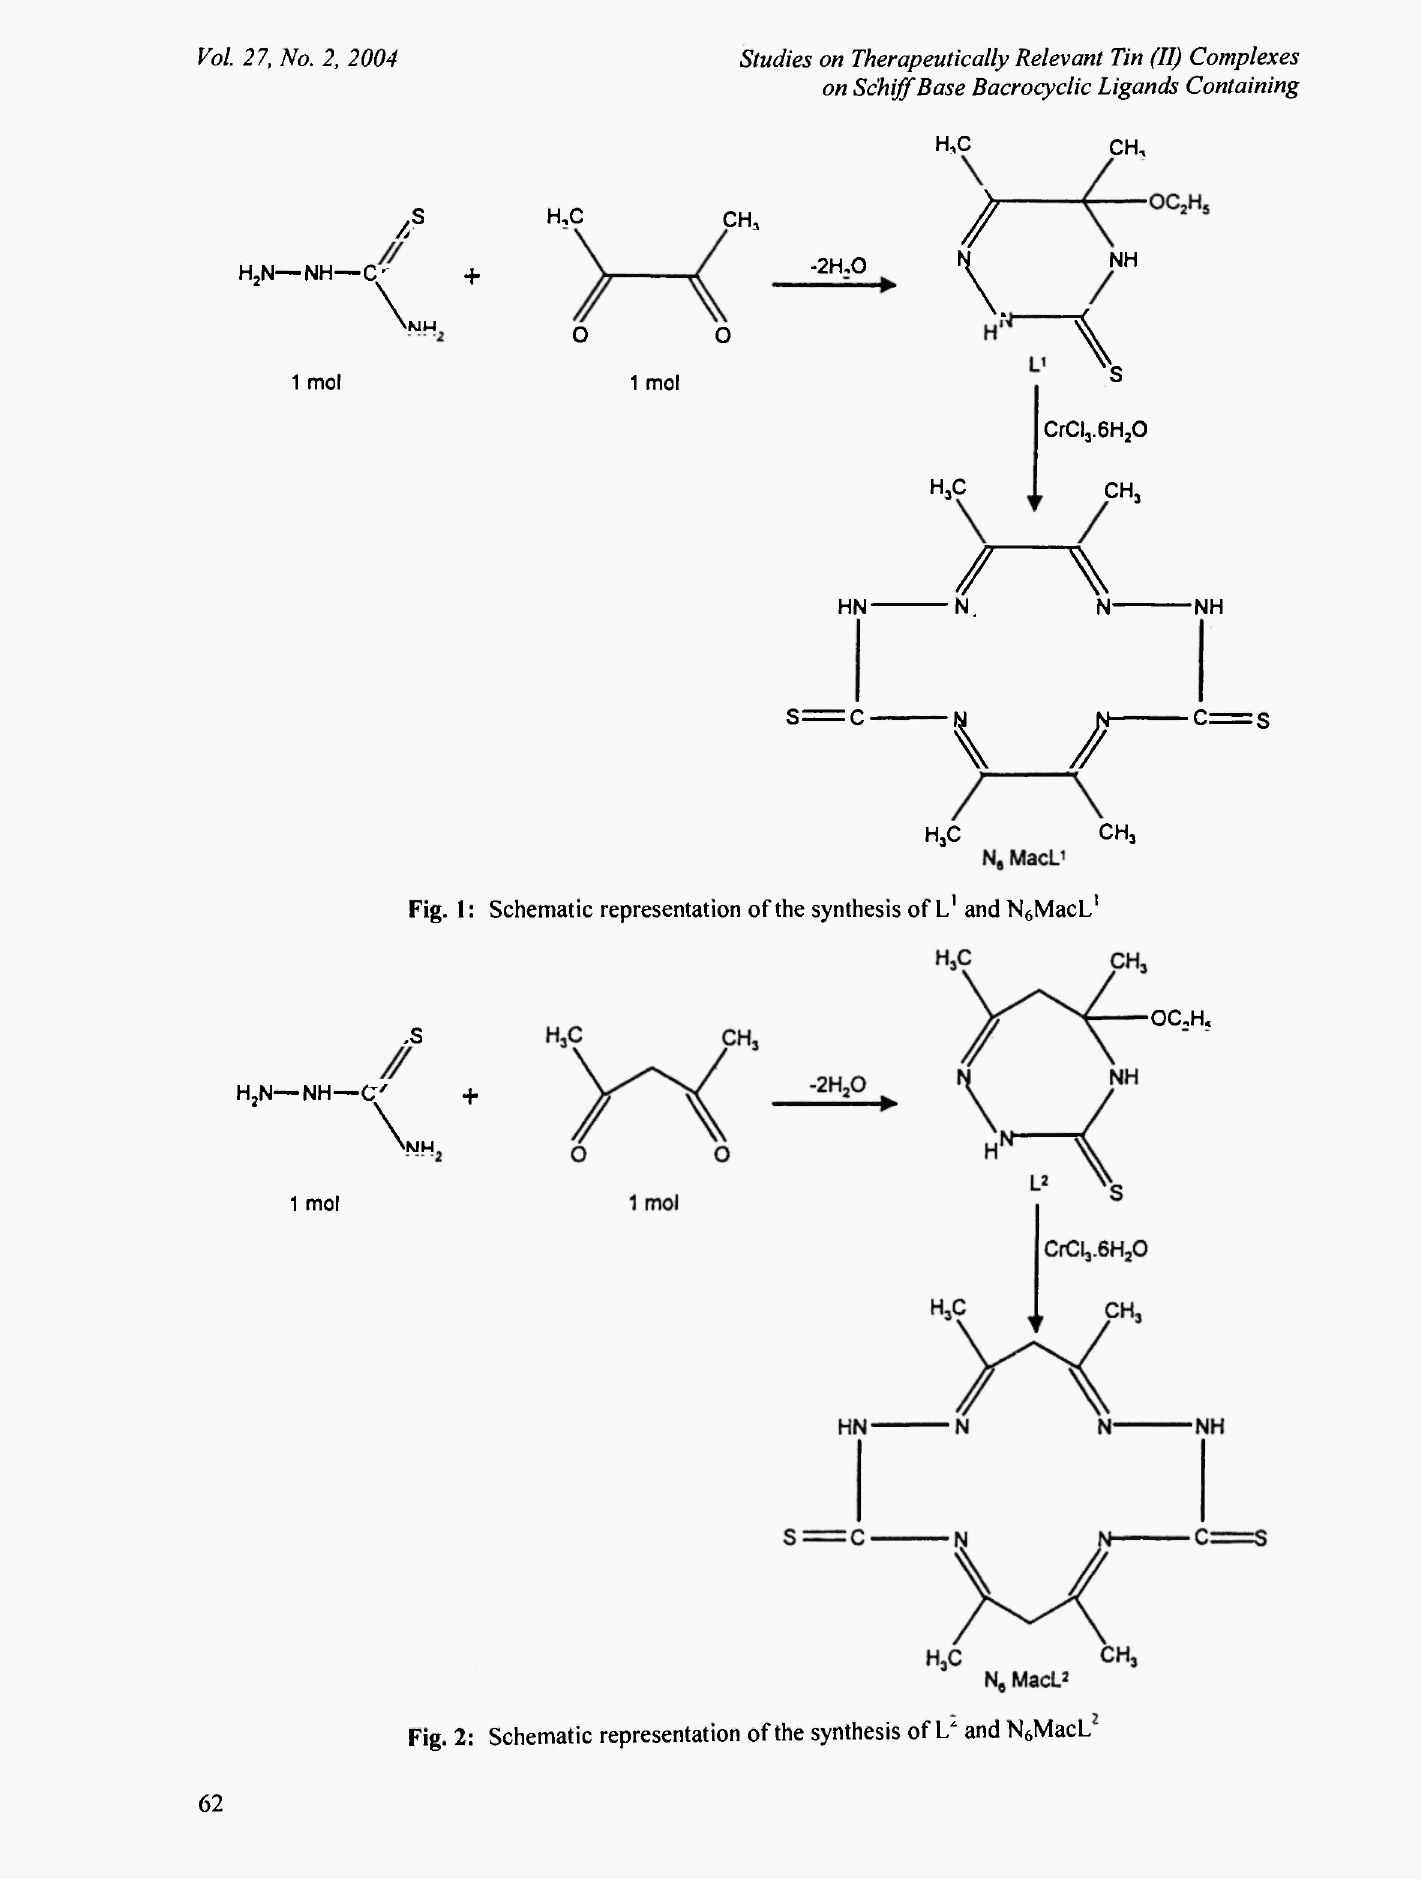
Fig. 1: Schematic representation of the synthesis of L 1 and N 6 MacL'